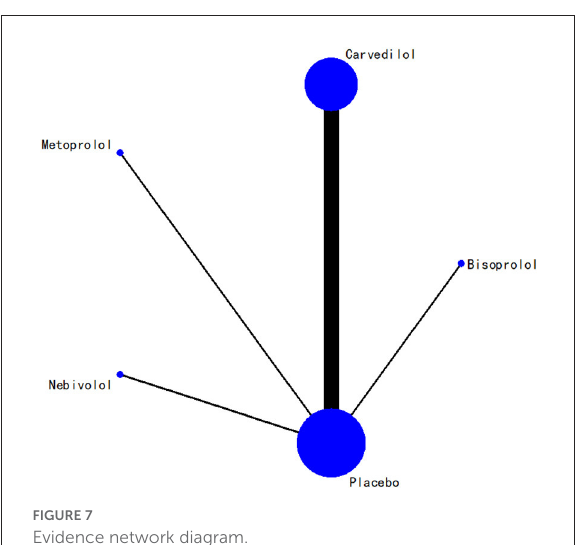
FIGURE7 Evidence network